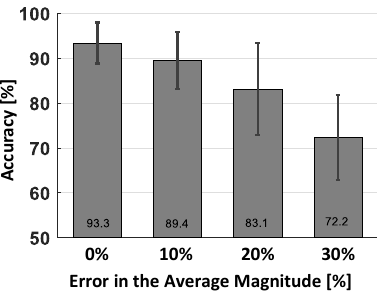
Figure 5. The performance of VERIFY by varying parameter values, i.e., by adding 0%, 10%, 20% and 30% errors to the membership functions of FIS.